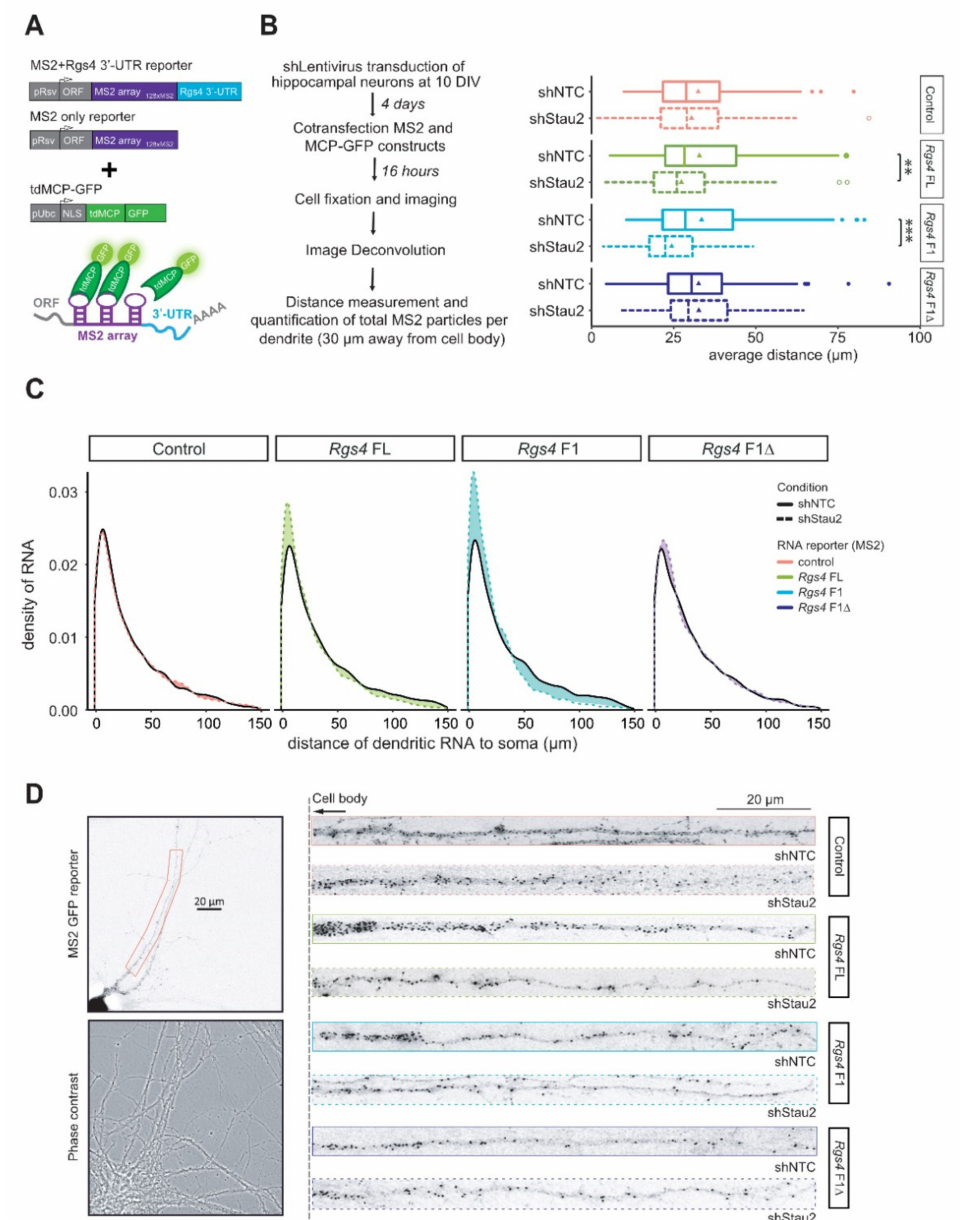
Figure 3. Stau2 mediates RNA structure dependent dendritic localization. ( A ) Scheme of the different MS2 + Rgs4 reporter constructs (only Rgs4 3 (cid:48) -UTR displayed) including control MS2, tdMCP-GFP expression cassettes and the MS2 system. pRSV, Rous sarcoma virus promoter; pUBC, Ubiquitin C promoter; ORF, open reading frame; NLS, nuclear localization signal; tdMCP, tandem MS2 coat protein; UTR, untranslated region; GFP, green fluorescent protein. ( B ) Experimental setup (left) and boxplot (right) of the average distance (in µ m) of MS2 particles per dendrite. Unpaired student’s t -test. DIV, days in vitro. Data from 4 independent biological replicates with at least 15 dendrites per replicate. Asterisks represent p -values (** p < 0.01, *** p < 0.001). ( C ) Density plot displaying the distance between MS2 particles in control (shNTC) and Stau2 KD conditions (shStau2) in co-transfected rat hippocampal neurons. Data represent the indicated MS2 + Rgs4 reporter mRNAs or control MS2. Colored areas represent differences in RNA distribution in dendrites upon Stau2 downregulation. ( D ) Left: Phase contrast and 128xMS2 GFP fluorescence in a rat hippocampal neuron at 14+1 DIV expressing both tdMCP-GFP and 128xMS2 + Rgs4 3 (cid:48) -UTR reporter RNA. Boxed region indicates a representative distal dendrite. Right: Deconvolved straightened images of dendrites are shown expressing both tdMCP-GFP and 128xMS2+ control, Rgs4 3 (cid:48) -UTR full length (FL), Rgs4 fragment 1 (F1) or Rgs4 fragment 1 deletion (F1 ∆ ), in control (shNTC) and Stau2 KD conditions (shStau2). Straightened images are cropped 30 µ m away from the cell body (dotted line) for better particle visibility. FL, full length; F1 fragment 1; F1 ∆ fragment 1 with 20 nt deletion. Data from 4 independent biological replicates with at least 15 dendrites per